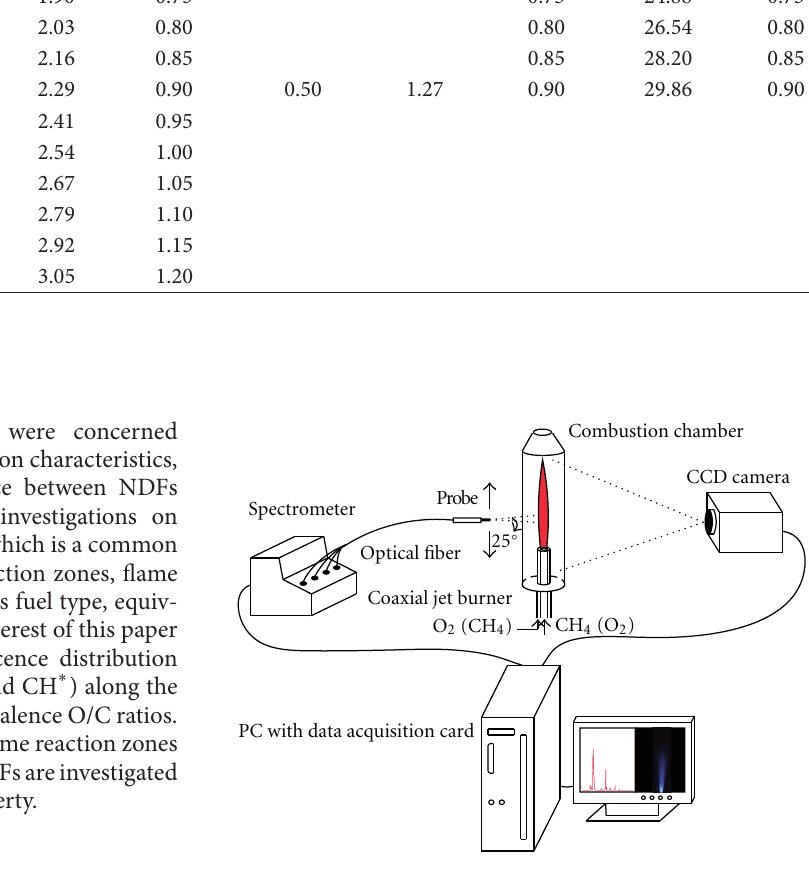
F 1: e schematic diagram of the experimental